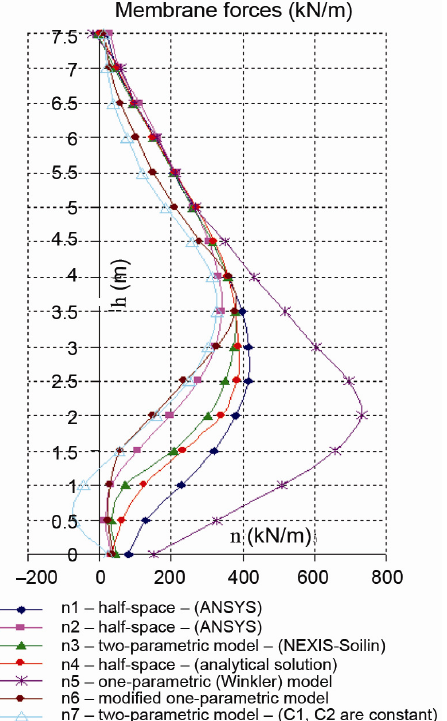
Fig. 10. Membrane forces